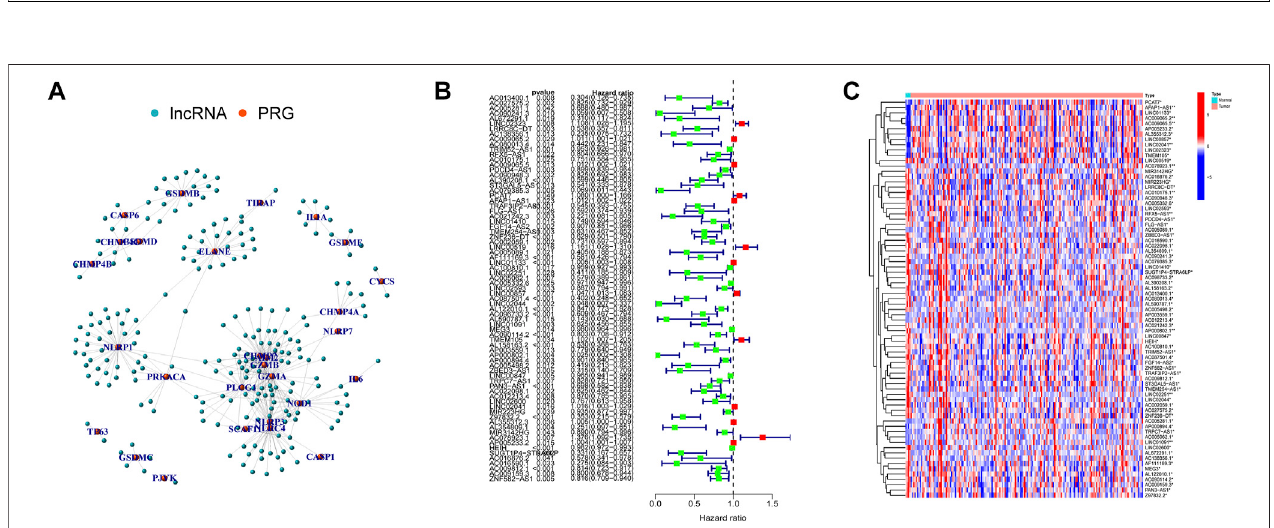
FIGURE 3 | Pyroptosis-related lncRNAs (PRlncRNAs) identi fi cation. (A) A total of226 PRlncRNAscorrelation network. (B) Univariate Cox analysiswasconducted to gain prognosis-related PRlncRNAs. (C) Heatmap showed the differential expression of 75 prognostic PRlncRNAs (* p < 0.05; ** p < 0.01).